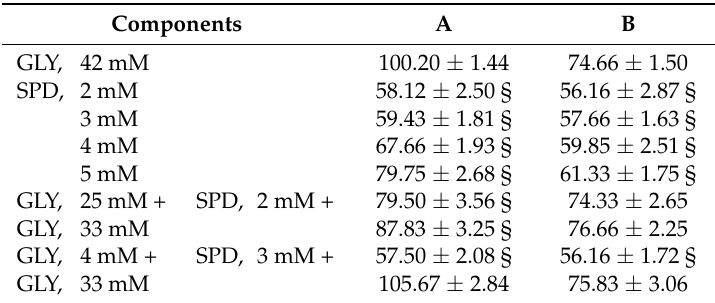
Table 4. Thickness (µm) of films obtained by casting 25°C-treated ( A ) and 80°C-treated ( B ) BVPC FFSs previously incubated at pH 8.0 in the presence of different concentrations of SPD and/or GLY *.